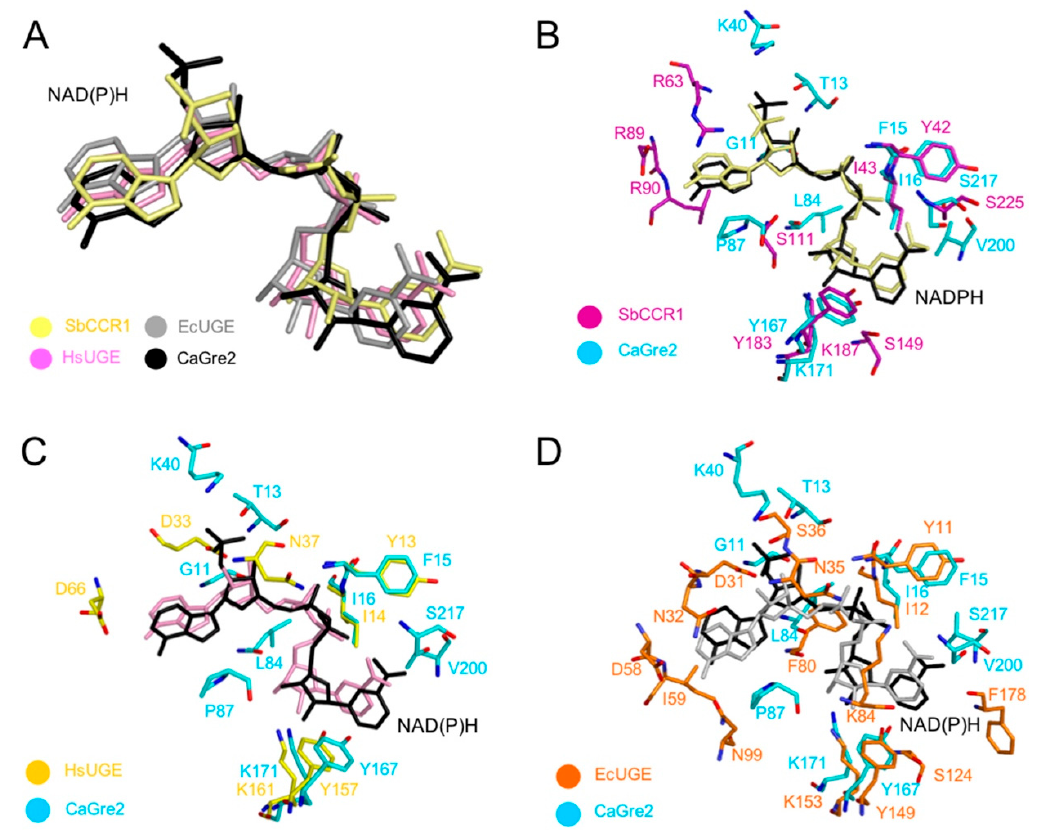
Figure 4. Comparisons of NAD(P)H conformations and NAD(P)H-interacting residues. ( A ) Superposition of NAD(P)H conformations in Sb CCR1 (PDB code, 5TQM; light yellow), Hs UGE (PDB code, 1EK5; pink), Ec UGE (PDB code, 1NAI; light gray), and Ca Gre2 (black) structures. Comparisons of NAD(P)H-interacting residues between Ca Gre2 (cyan), ( B ) Sb CCR1 (magenta), ( C ) Hs UGE (yellow), and ( D ) Ec UGE (orange).